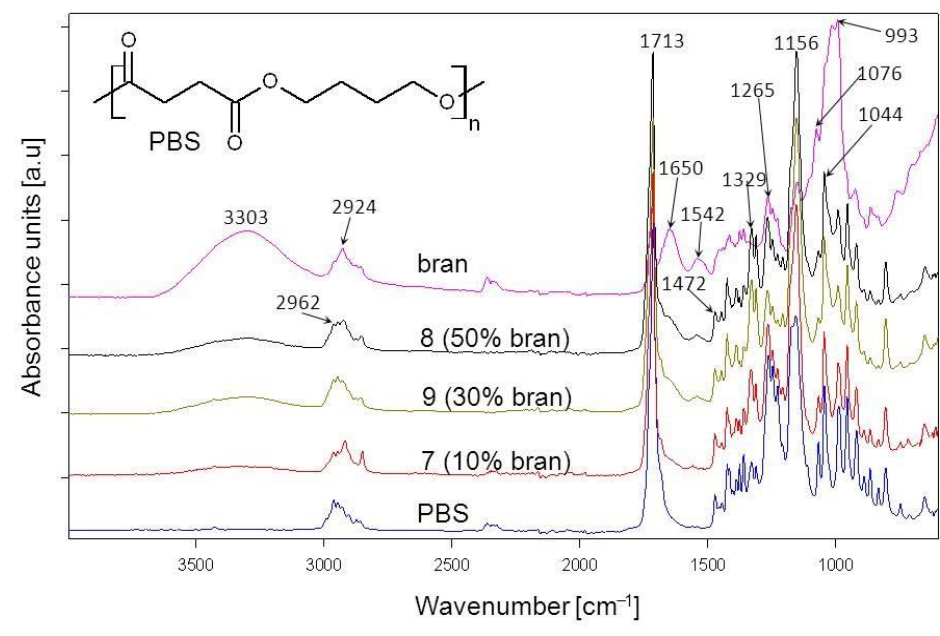
Figure 12. ATR-FTIR spectra of PBS, bran and their composites obtained pursuant to research plan system 7, 8, 9 with different bran content.